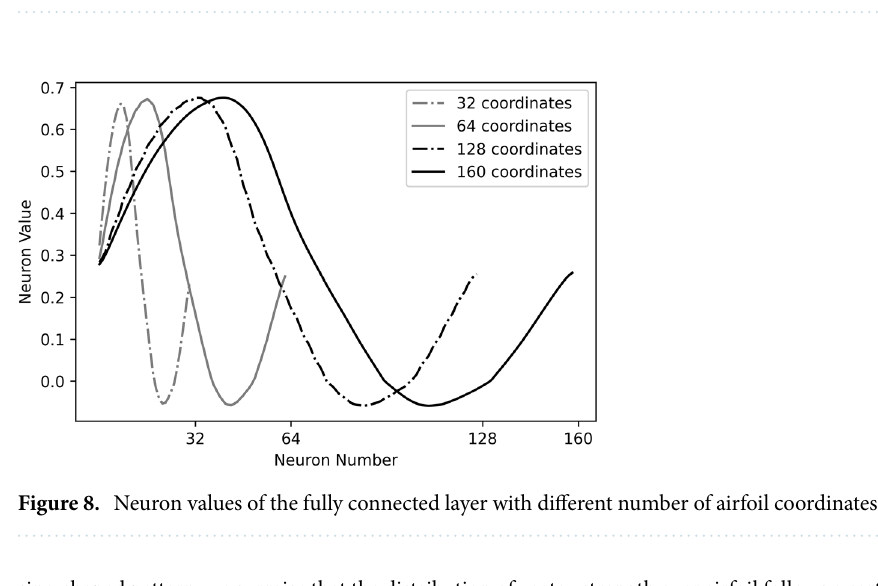
Figure 7. Comparison of the converged layer pattern with 160 panels vortex strength distribution.